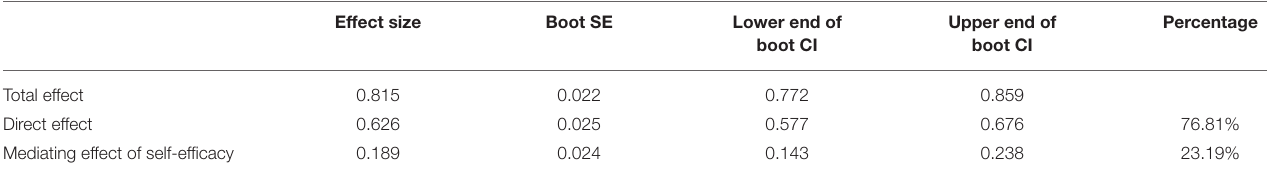
TABLE 5 | Total, direct, and mediating effects of self-efficacy in the relationship between hospital culture and healthcare workers’ perceived provision of patient-centered care.